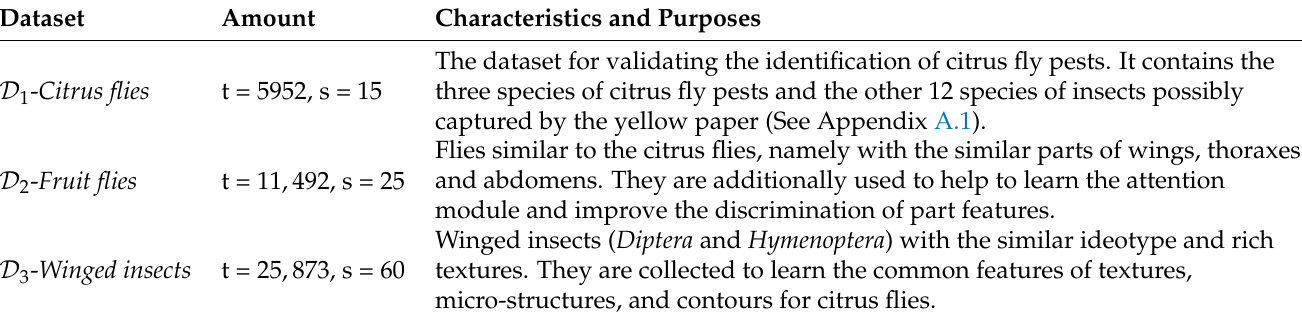
Table 1. Datasets for classifier training and feature learning. The second column describes the number of samples (t) and the number of species (s). The species in D 1 , D 2 , and D 3 are not overlapped. Dataset Amount Characteristics and